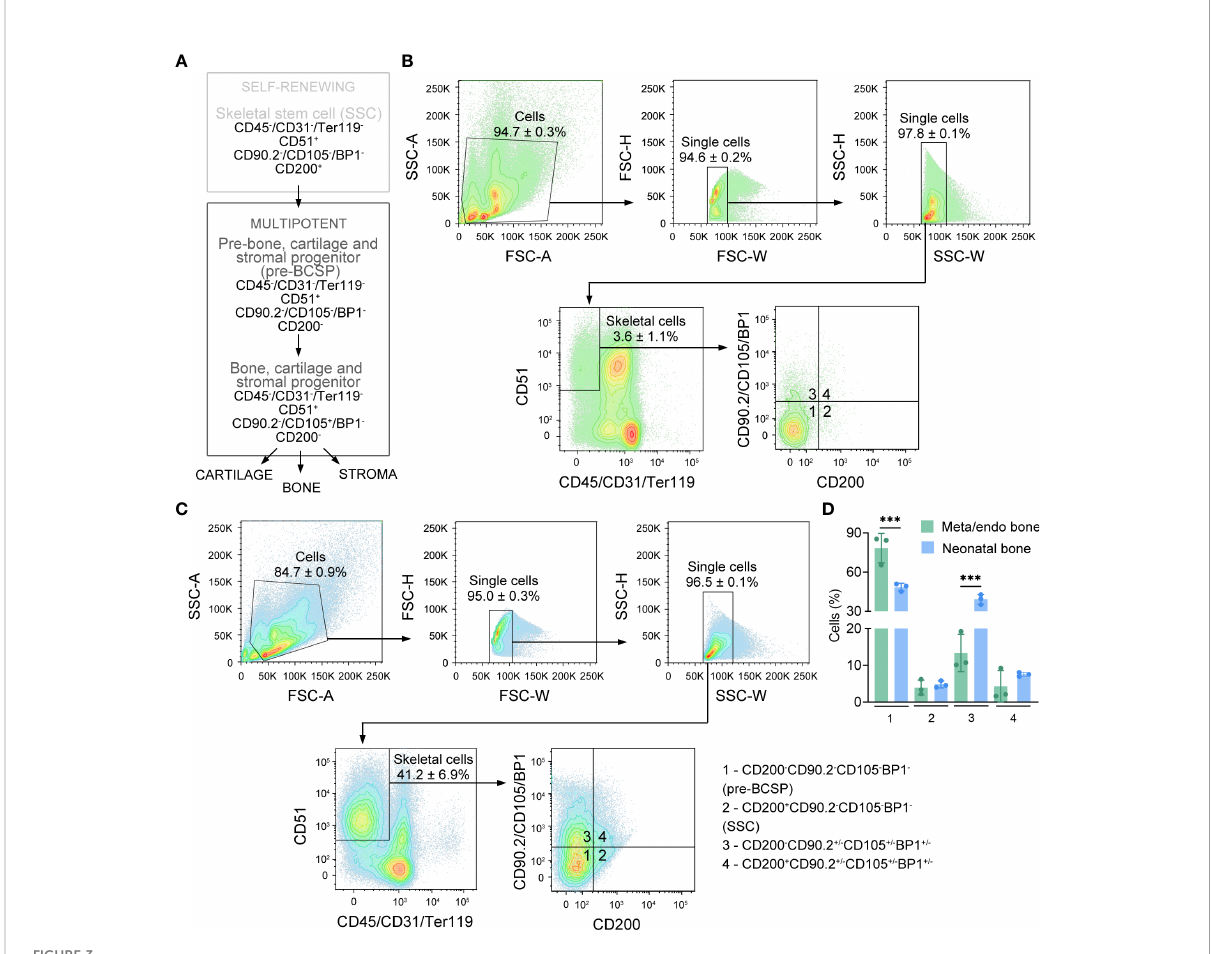
FIGURE 3 Freshly isolated metaphyseal/endosteal bone cells express surface markers of putative stem and progenitor cells. (A) Schematic representation of the mouse skeletal stem cell tree (adapted from (19)). (B) Contour plots showing the gating strategy used for fl ow cytometry-based quanti fi cation of different skeletal cell subpopulations in freshly isolated metaphyseal/endosteal cells (n=3). (C) Contour plots showing the gating strategy used for fl ow cytometry-based quanti fi cation of different skeletal cell subpopulations in freshly isolated neonatal cells (n=3). (D) Quanti fi cation of different cell subpopulations in metaphyseal/endosteal and neonatal SSPCs based on CD200/CD90.2/CD105/BP1 expression (n=3). SSC is skeletal stem cell, pre-BCSP is pre-bone, cartilage and stromal progenitor. Data are shown as mean ± SD. ***p<0.001 (Two-way ANOVA with Tukey ’ s multiple comparison